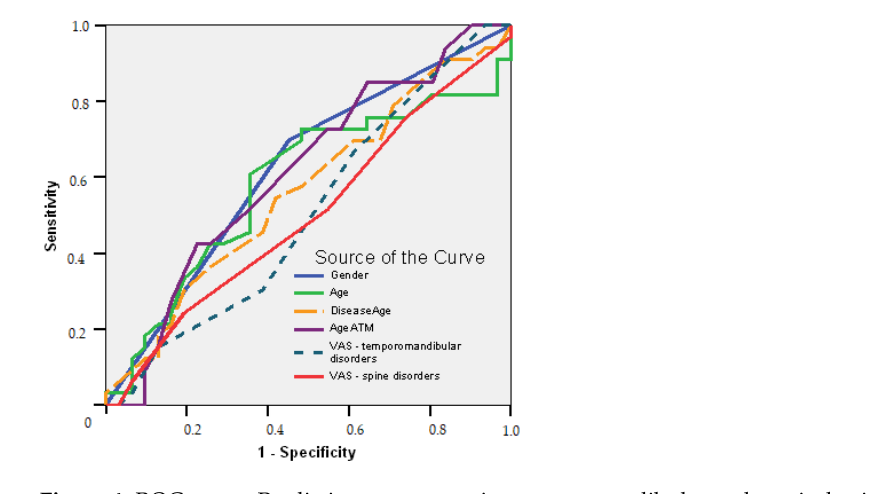
Figure 4. ROC curve. Predictive parameters in temporomandibular and cervical spine disorders. After 3 months of physiotherapeutic treatment, joint noise testing showed a significant decrease in the experimental group. The frequency of joint noises decreased significantly, especially in right and left laterality ( p < 0.001), mouth opening/closing ( p < 0.005), and protrusion–retrusion ( p < 0.013, Table 2). Table 2. Joint noise testing.